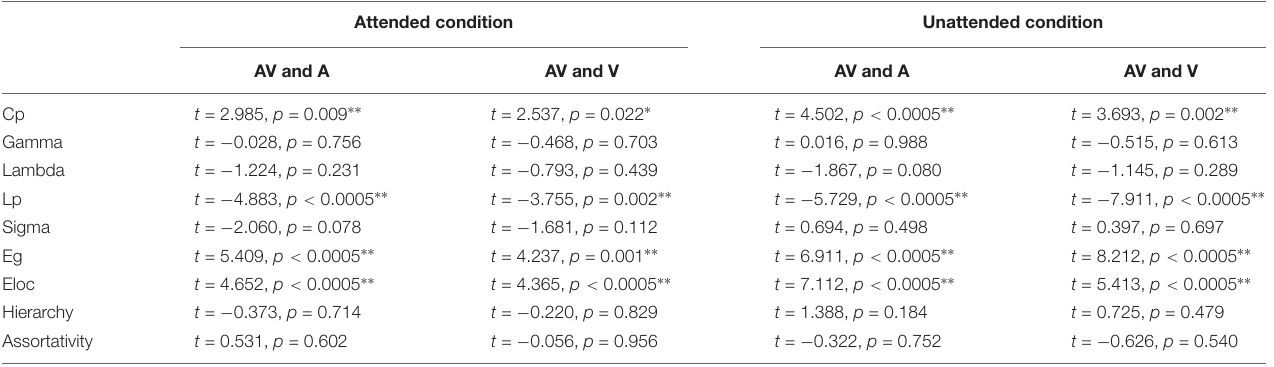
TABLE 1 | The analysis results of paired t -test between bimodal AV and unimodal A/V networks in attended and unattended conditions respectively. Attended condition Unattended condition AV and